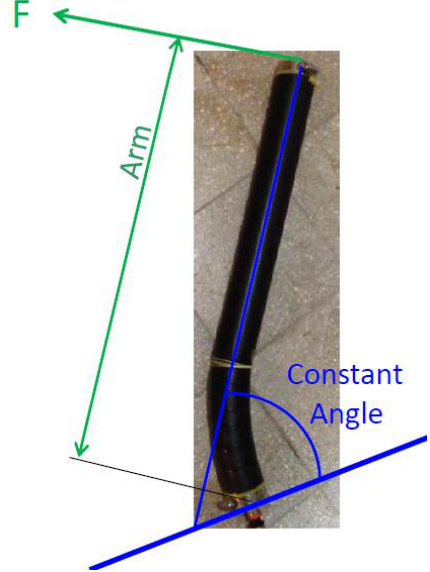
Figure 9. Blocked moment Experiment.